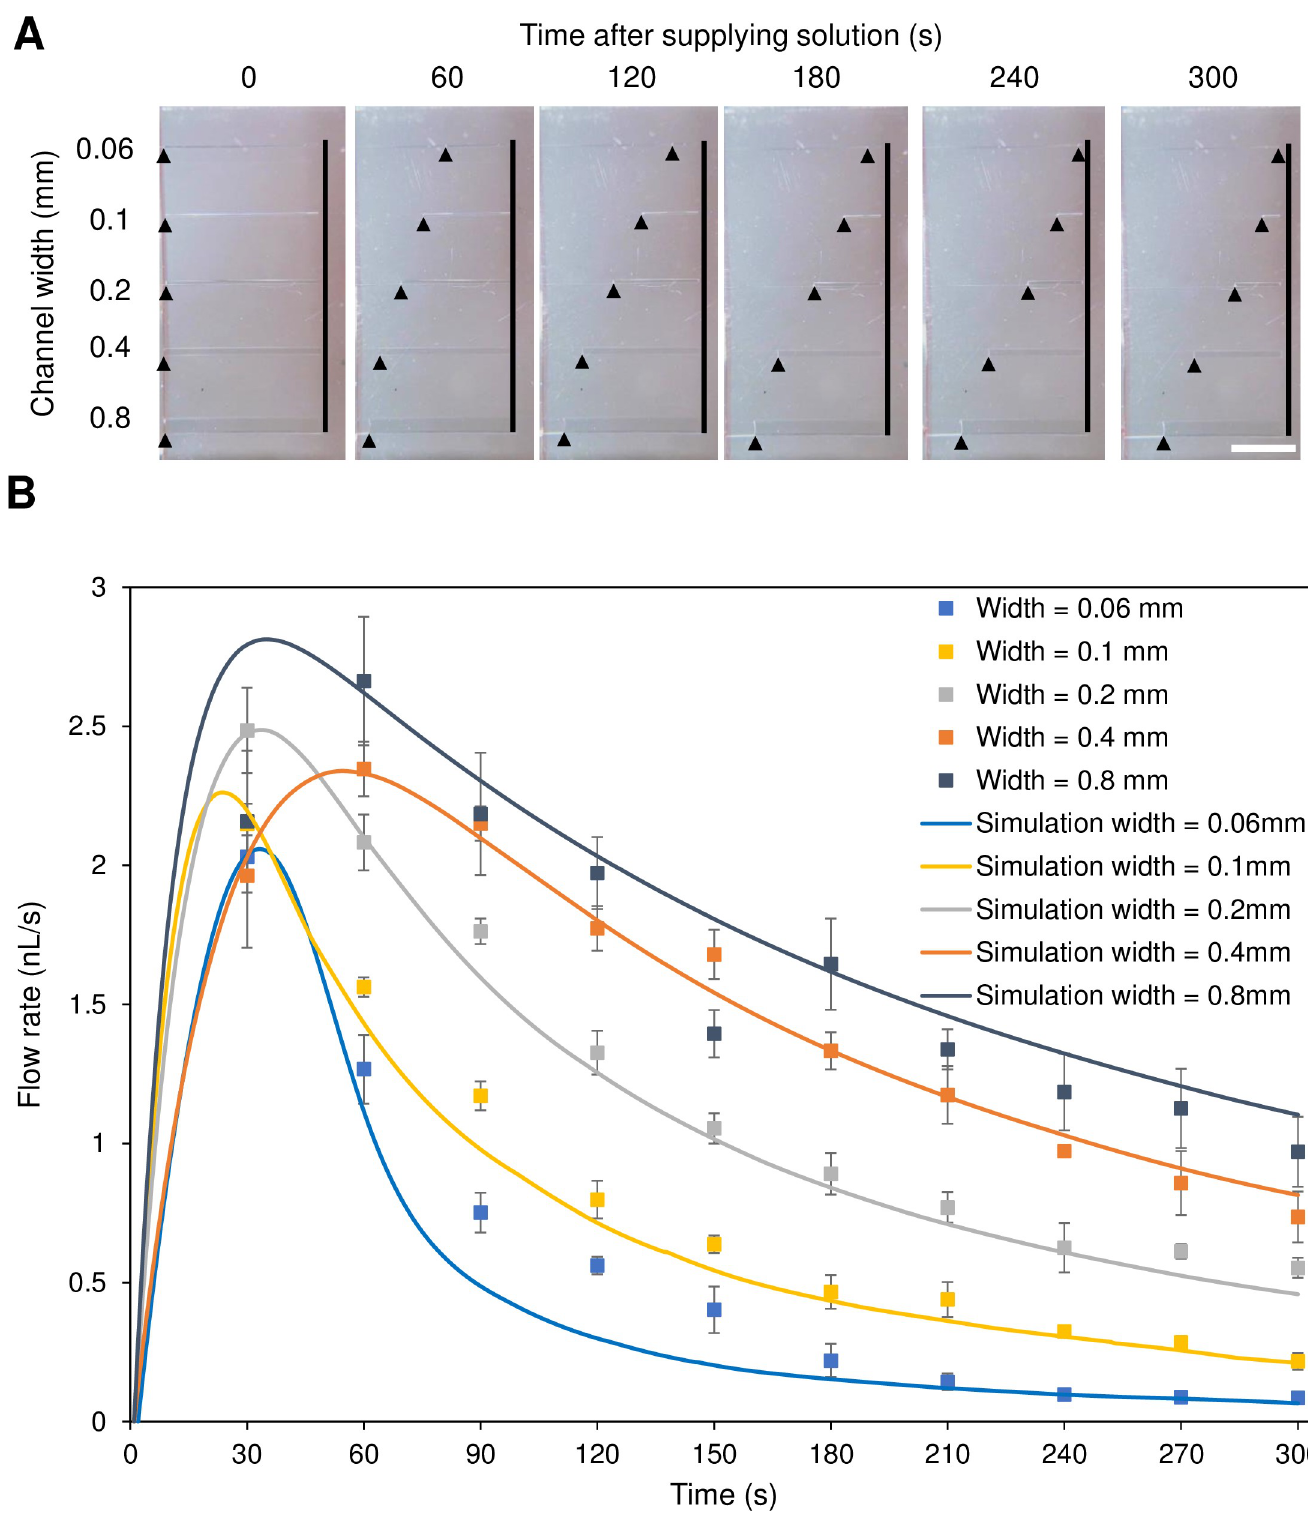
Fig 4. Photographs showing the appearance of cross-linked albumin solution and graphical time-courses of flow rates. (A) Appearance of cross-linked albumin solution (1 mPa � s) at 0, 30, 60, 120, 180, 240, and 300 s after supplying the solution at the end of the 1 mm-length micro-channels (height: 0.2 mm) of degassed PDMS molds with accumulated vacuum pressure. Arrow heads and lines indicate the head points of cross-linked albumin solution penetrating into the micro-channels and